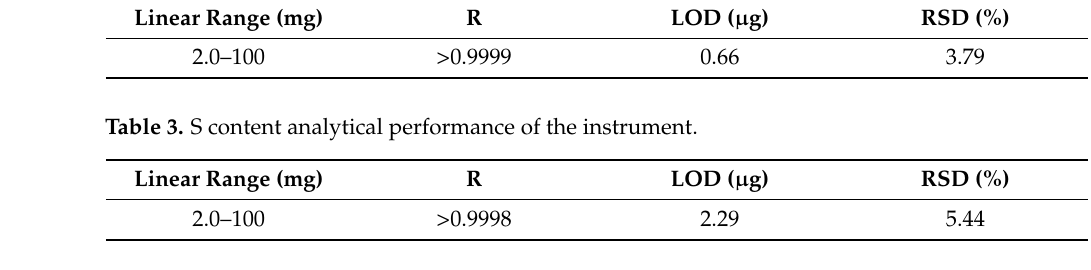
Table 4. Results of N recovery rate (%) in Chlamys farre standard substances (n = 6).